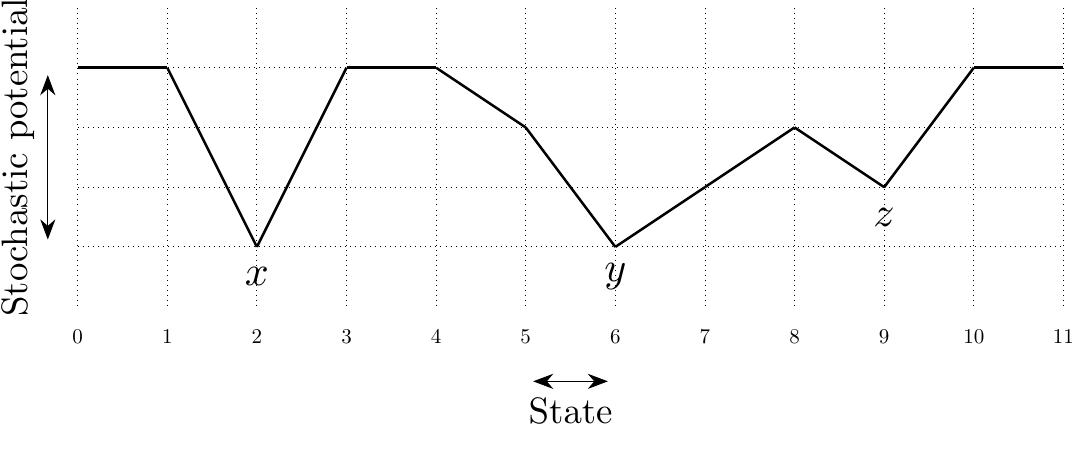
Figure 8. Length, steepness and cost of transitions between conventions. The state space is the set of integers from 0 to 11. The only transitions that occur with positive probability are between adjacent states. The cost of a transition, the exponential decay rate of its probability, equals the change in height on the vertical axis if this quantity is positive. Otherwise, the cost is zero. For example, the cost of 9 10 is two and the cost of 10 9 is zero. The length of the path from x to y is one, as only a single → → transition on the path, 2 3, has strictly positive cost and is therefore an error . However, this transition → is relatively steep , with a cost of three. In contrast, the path from y to z has length two as both 6 and 7 8 are errors, but is less steep as each error only has a cost of one, thus the total cost of the path → is two. States x and y minimize stochastic potential and are thus stochastically stable